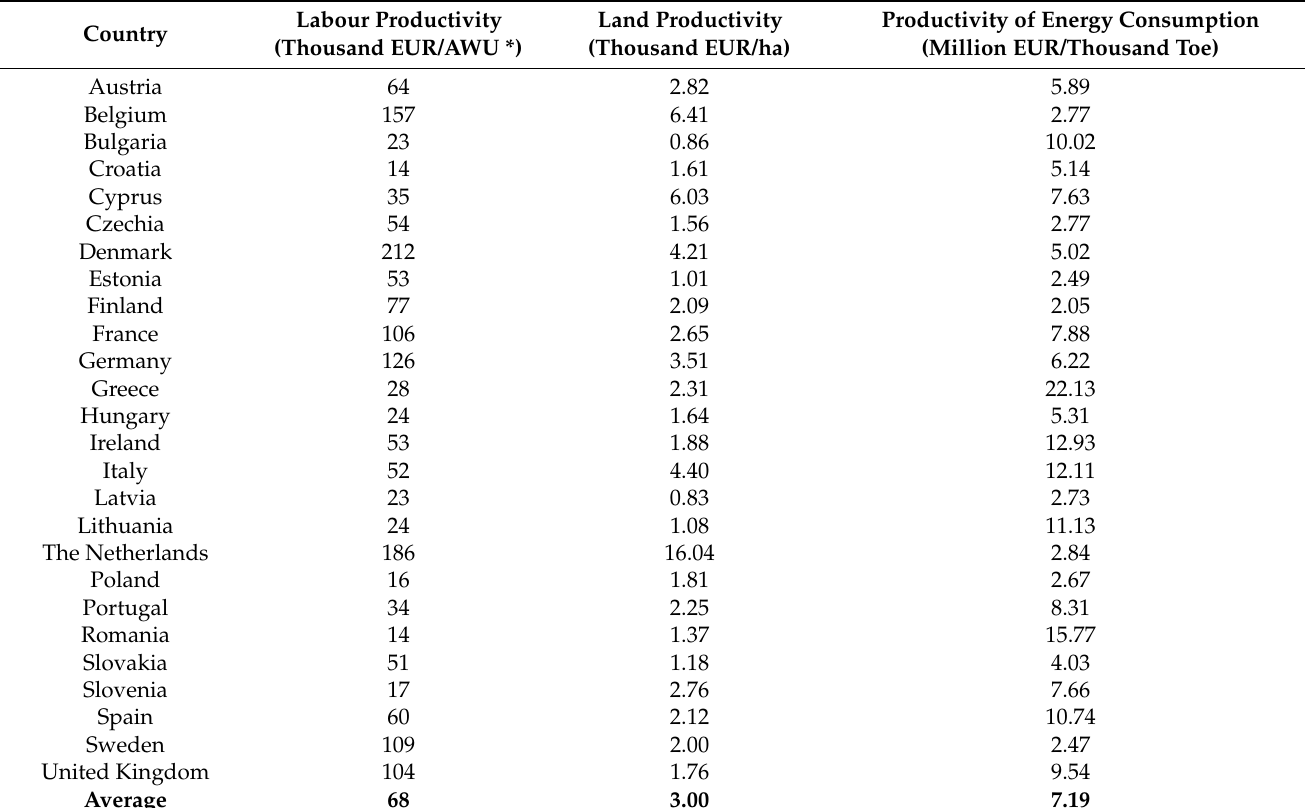
Table 3. Labour productivity, land productivity and productivity of energy consumption in agriculture in EU (2019). Labour Productivity Country (Thousand EUR/AWU *)